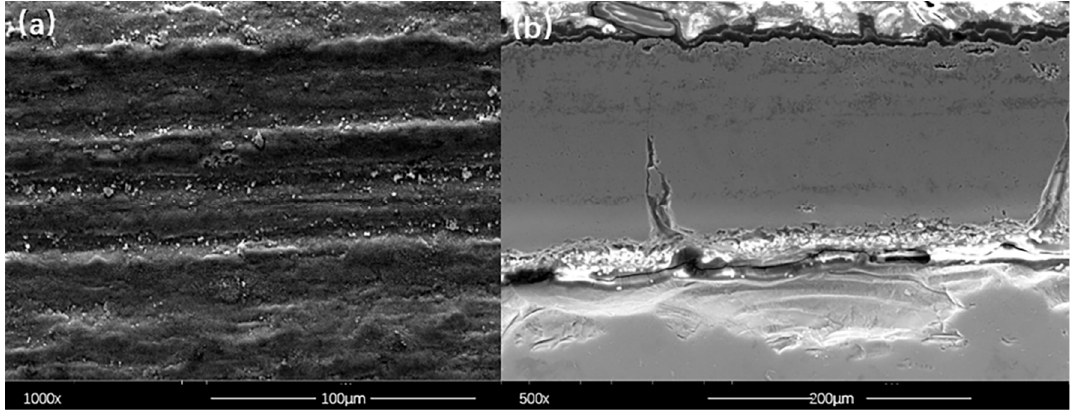
Figure 1. ( a ) Surface wear morphology of Ti-6Al-4V alloy; ( b ) cross section morphology of oxide layer.